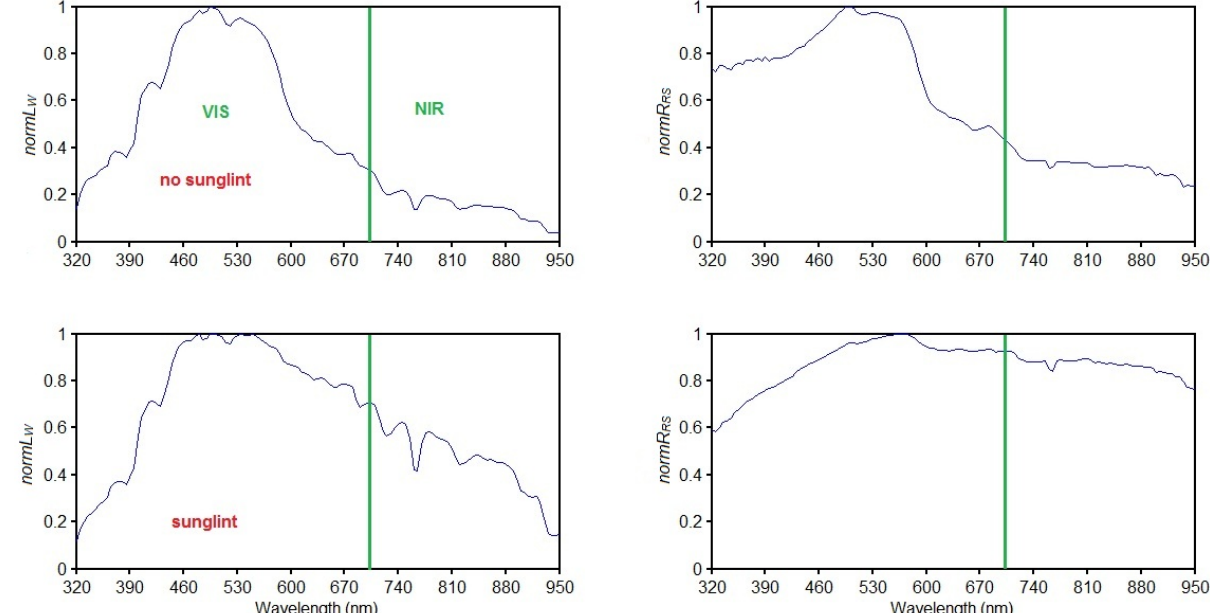
Figure 6. Normalised mean spectral shapes for the sunglint free set Nns ( top ) and sunglint set Ns ( bottom ). The green line highlights the spectral limits for the VIS ( λ = 320–700 nm) and NIR ( λ = 700–950